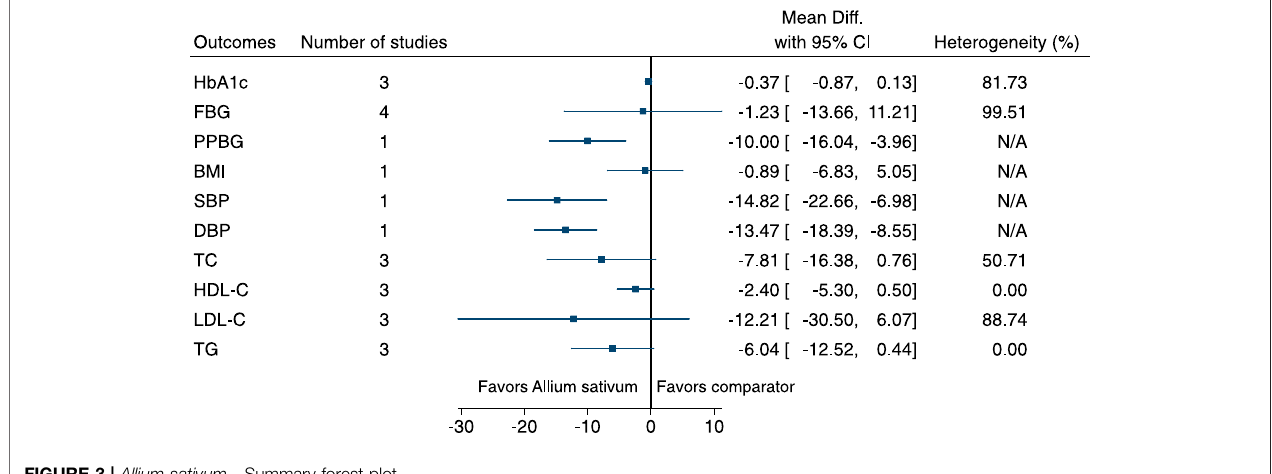
FIGURE 3 | Allium sativum — Summary forest plot.